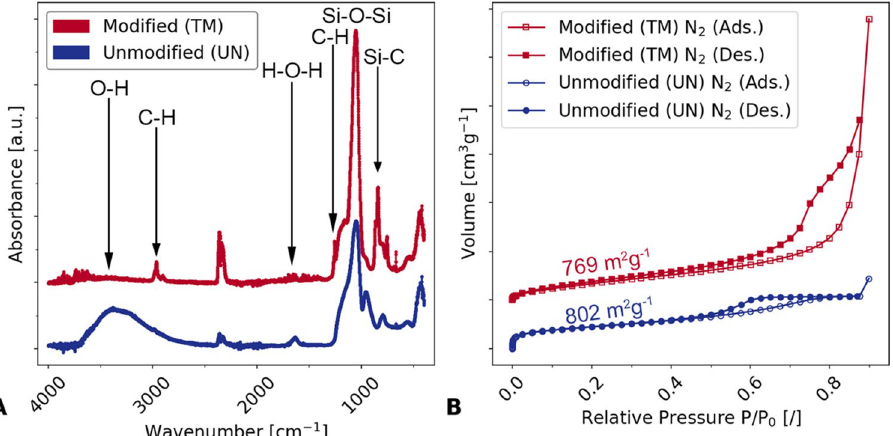
Figure 2. ( A ) ATR-FTIR of the TMCS surface-modified TM (red) and the unmodified UN (blue) dried sol– gel samples confirm the successful modification of the gel surface with TMCS. The TM sample is shifted by a Y-offset. ( B ) Nitrogen adsorption (Ads.)—desorption (Des.) isotherms of the dried UN (blue) and the y-offset shifted TM (red) sample show similarities for the specific surface area evaluation after Brunauer–Emmet–Teller (BET) and severely different volumes at high relative pressure.